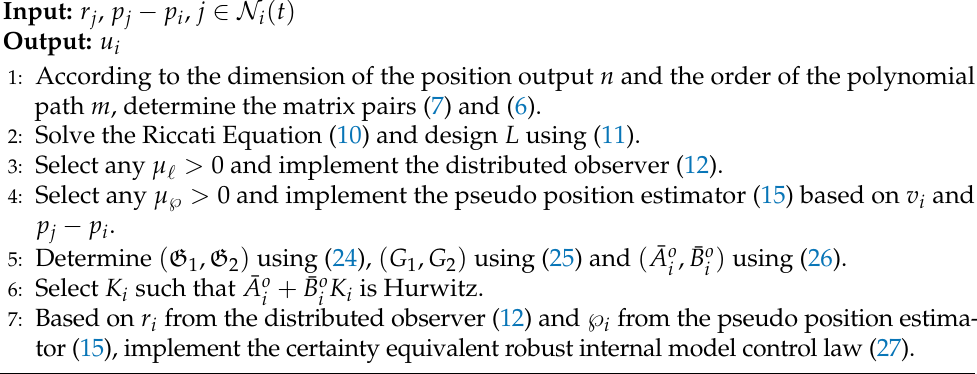
Algorithm 1 Calculating the control input by the distributed robust control scheme for the i th